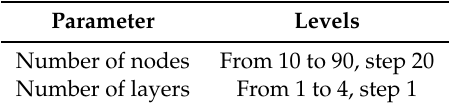
Table 1. Parameter and levels of deep learning